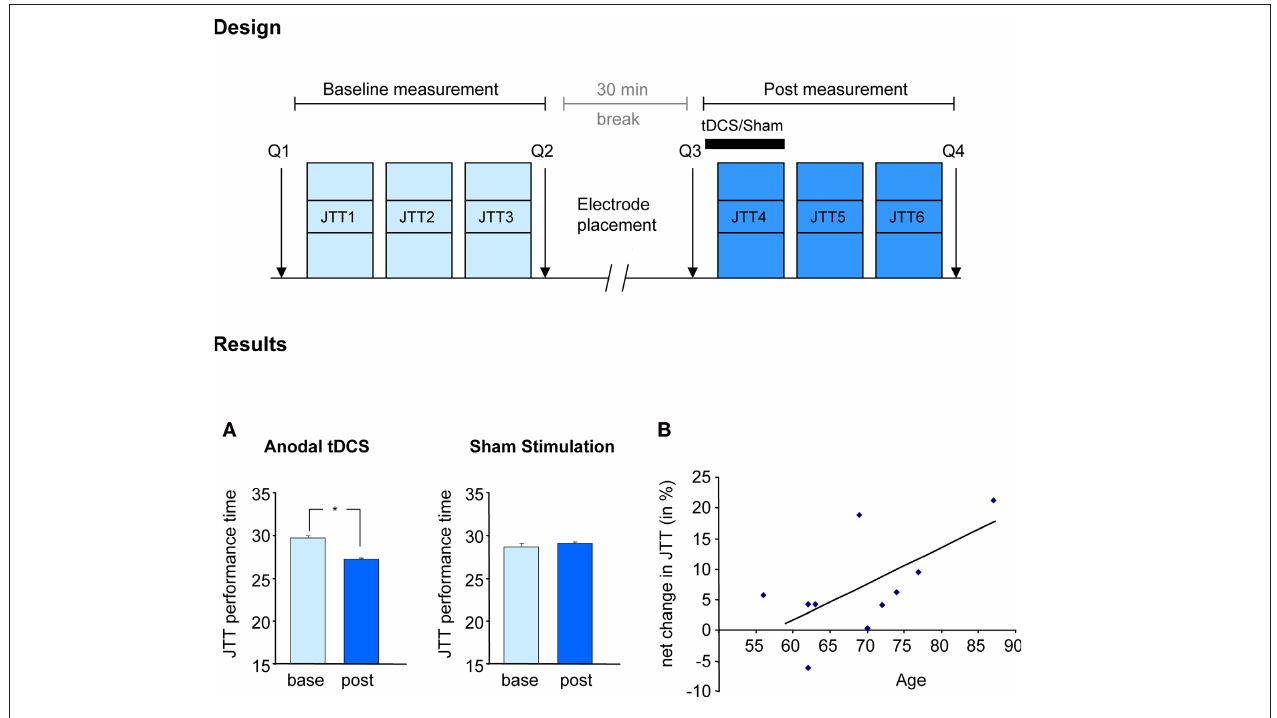
fatigue during the experiment where given (Q ). Results : (A) tDCS but not 1–4 Sham stimulation resulted in shorter total time of JTT (JTT vs JTT 1–3 4–6